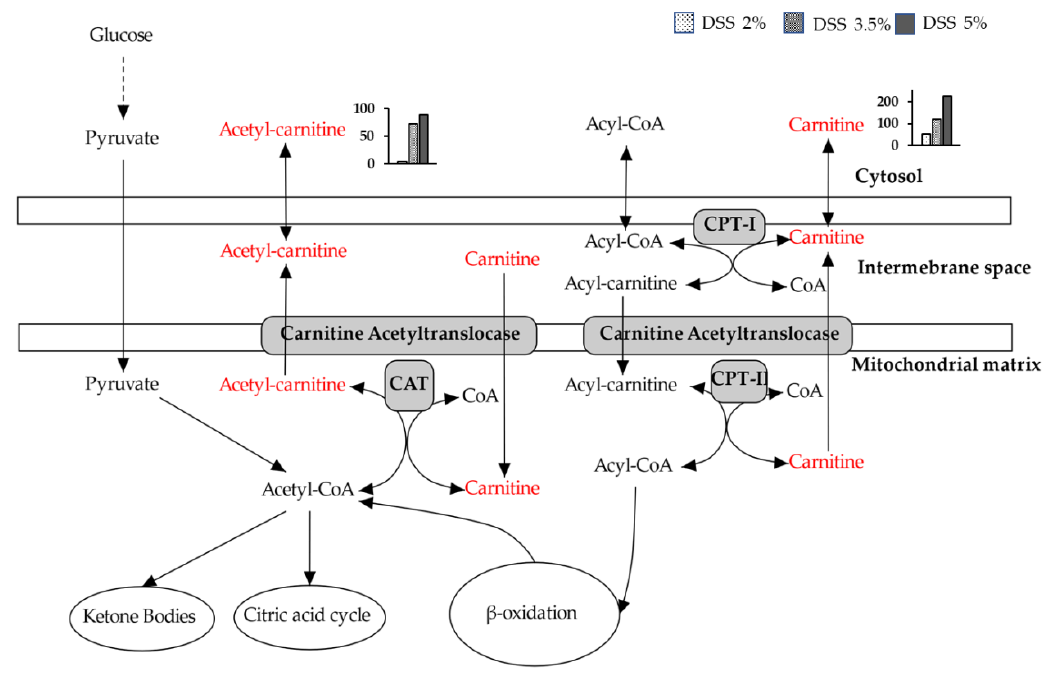
Figure 10. Overview of acetyl-carnitine- and carnitine-related metabolism in the liver of mice with ulcerative colitis (UC).